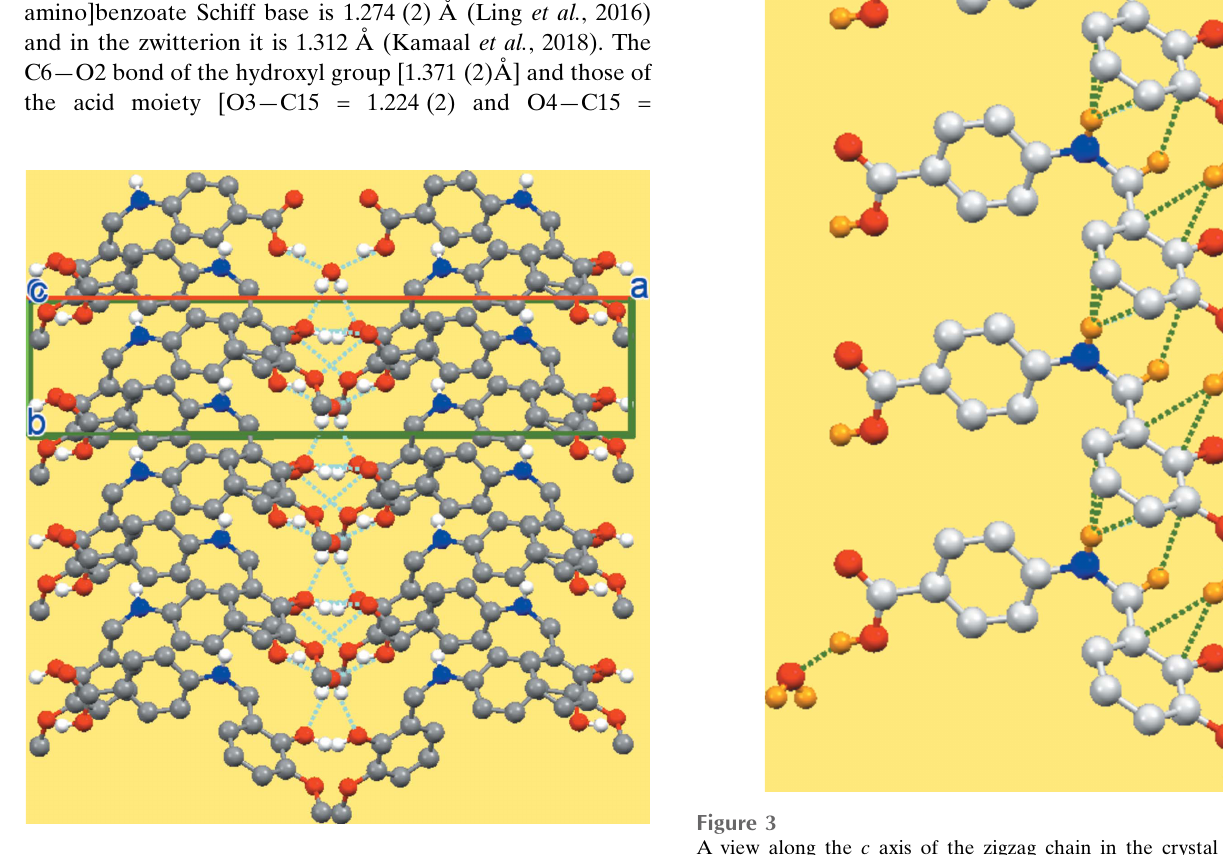
Figure 2 A view of the crystal packing of the title compound.